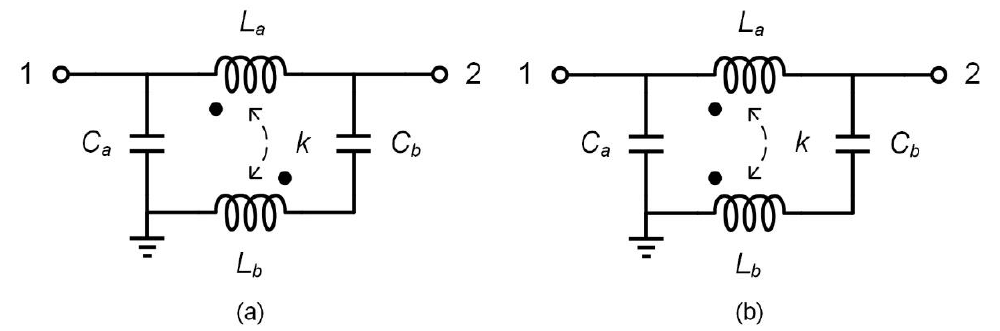
Figure 2. ( a ) Inversely and ( b ) non-inversely coupled transmission lines based resonators.